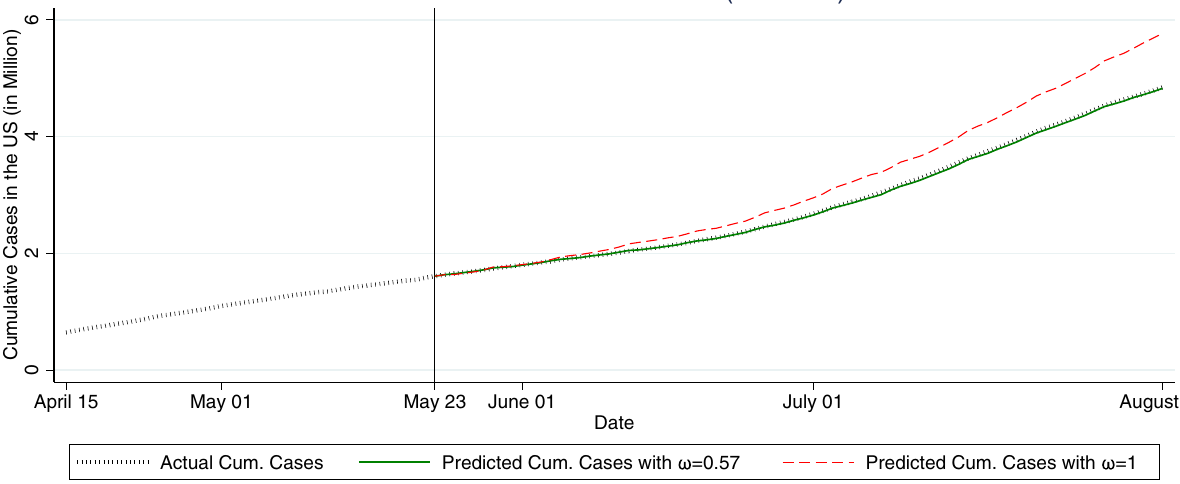
Figure 1. Out-of-sample fit comparisons of the US between our model and standard SIR model. The vertical line on May 23, 2020 indicates the last date used to estimate each